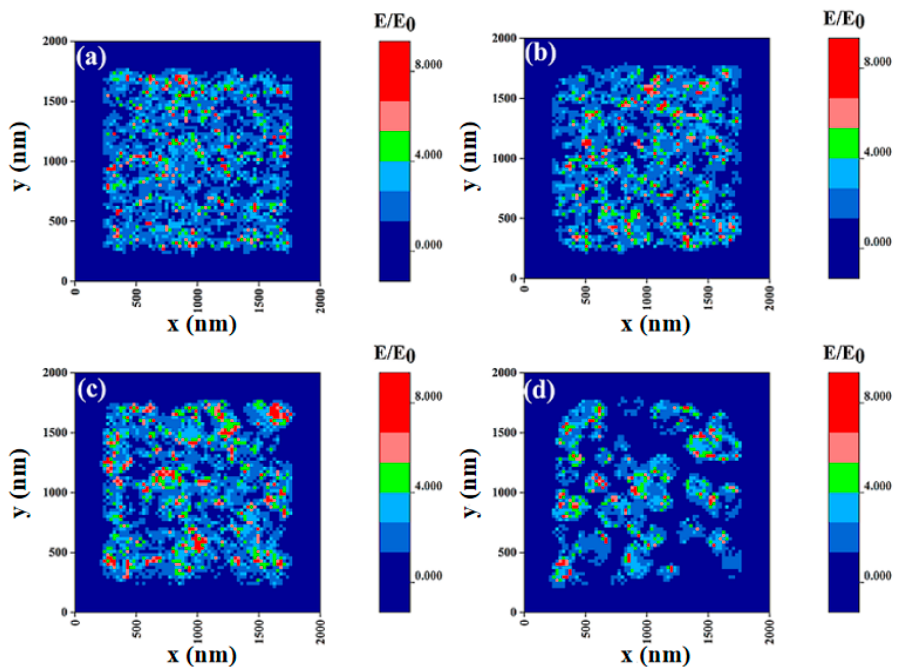
Figure 6. Electromagnetic field distribution of 10 nm Au films ( a ) without annealing and annealed at ( b ) 150 °C, ( c ) 250 °C and ( d ) 350 °C.